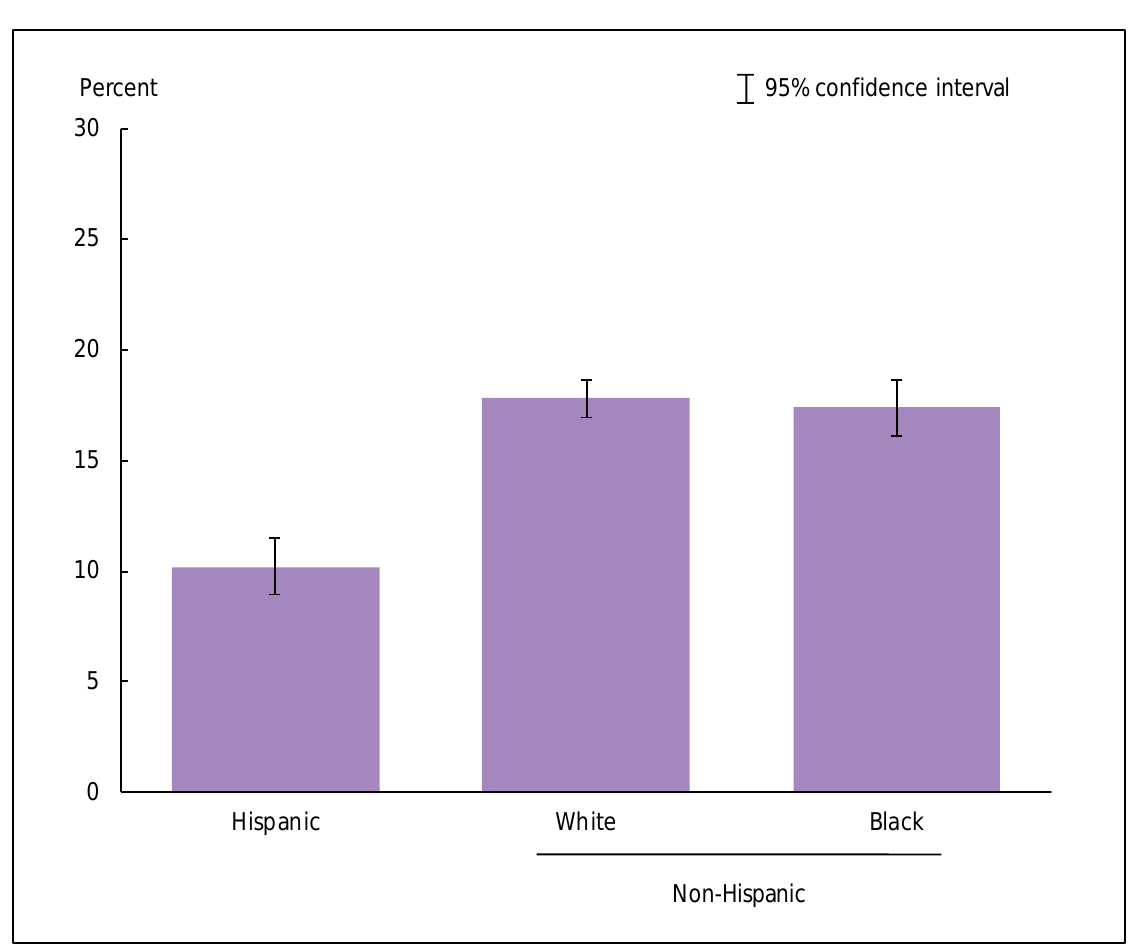
Figure 8.4. Age-sex-adjusted prevalence of current cigarette smoking among adults aged 18 and over, by race and ethnicity: United States,